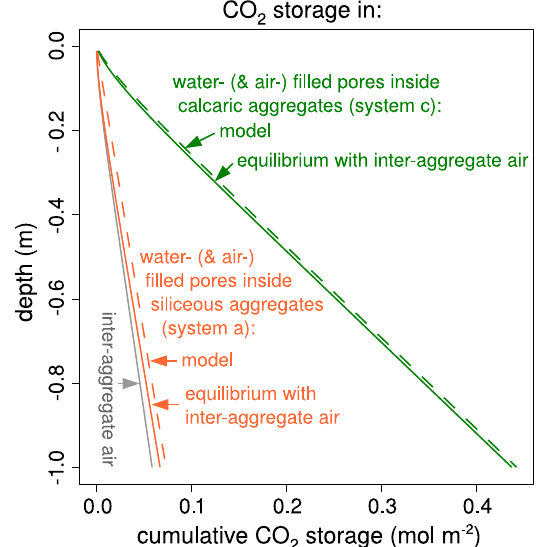
Fig. 9. Cumulative CO 2 storage in the inter-aggregate air and in the mainly water-filled pore-space inside the siliceous and calcaric aggregates, based on the modelled CO 2 partial pressures (system a and c) (Fig. 8). Additionally, the CO 2 storage inside the aggregates is plotted for on an assumed equilibrium between the inter- and intra-aggregate pore-space (no intra-aggregate CO 2 gradient).